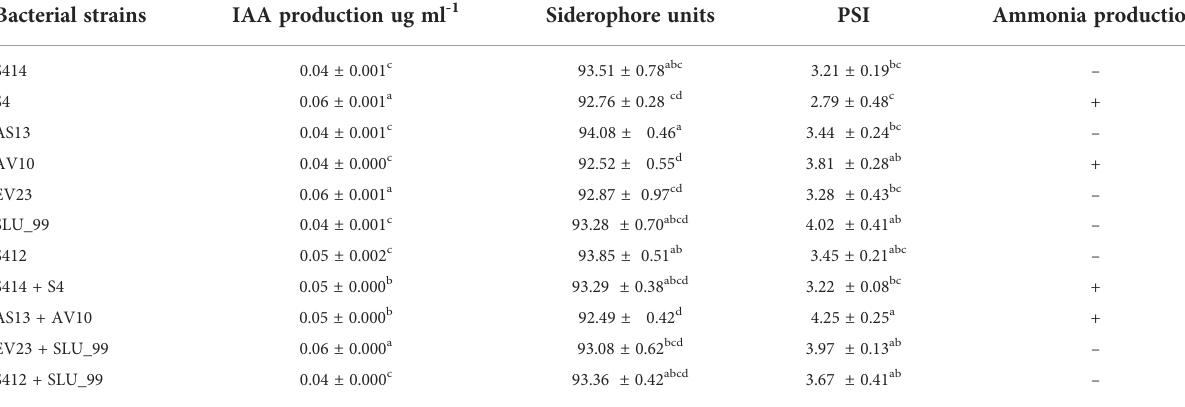
TABLE 3 Production of different plant growth-promoting traits by bacteria grown in vitro